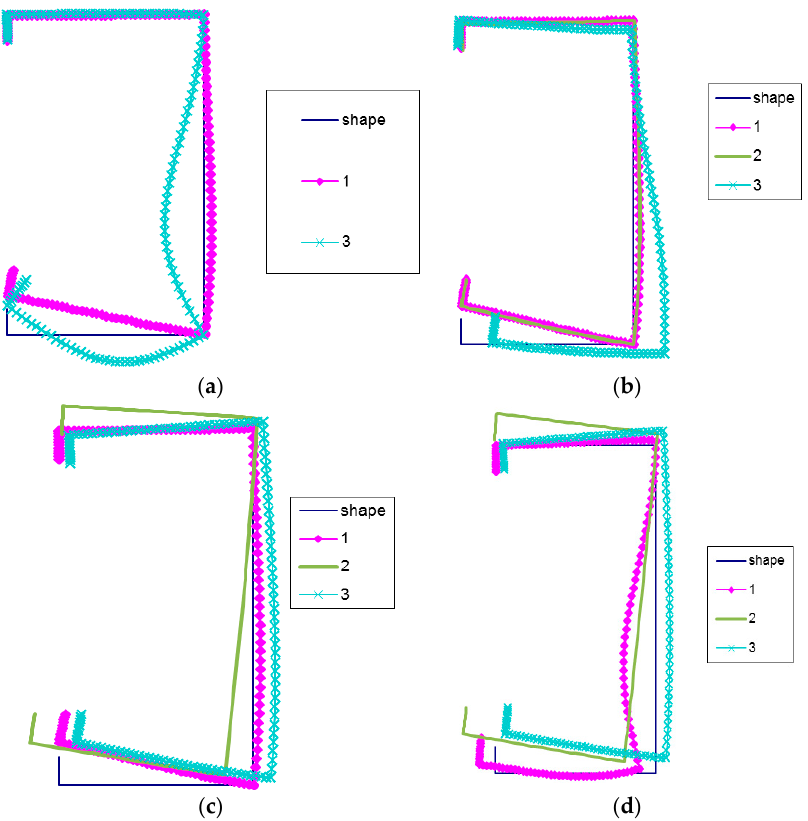
Figure 3. ( a ) Buckling modes for LC-1 beam lengths L = 200 mm, ( b ) Buckling modes for LC-1 beam lengths L = 500 mm, ( c ) Buckling modes for LC-1 beam lengths L = 1500 mm, ( d ) Buckling modes for LC-1 beam lengths L = 2050